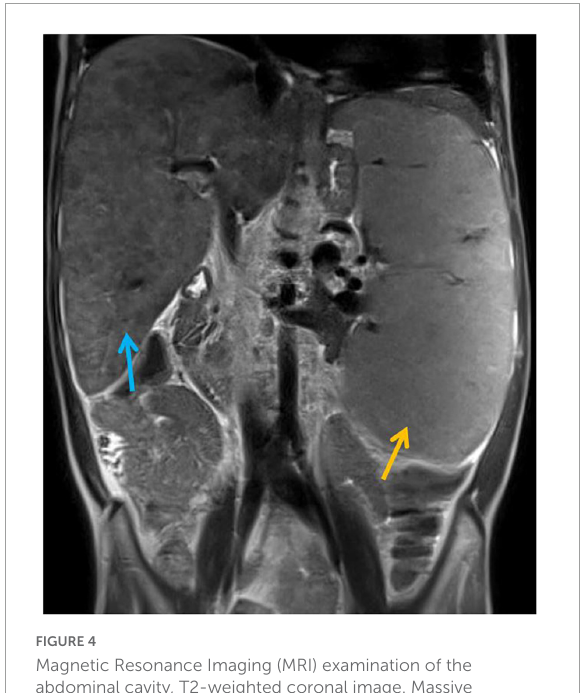
FIGURE4 Magnetic Resonance Imaging (MRI) examination of the abdominal cavity, T2-weighted coronal image. Massive hepatosplenomegaly (the liver and spleen are marked with blue and orange arrows, respectively) and granulomatous lesions in the liver and spleen resulting in severe portal hypertension, hypersplenism, and ultimately, hepato-renal